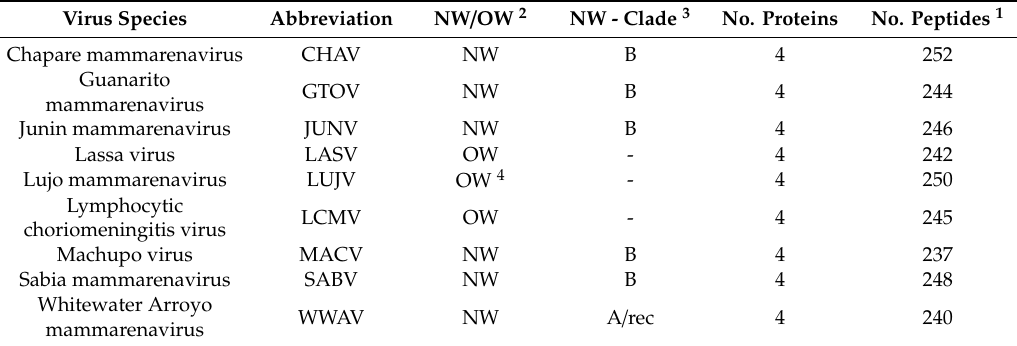
Table 1. Alphabetically ordered list of arenavirus species used for the performance benchmarking. The reader is referred to [23] for further details on these